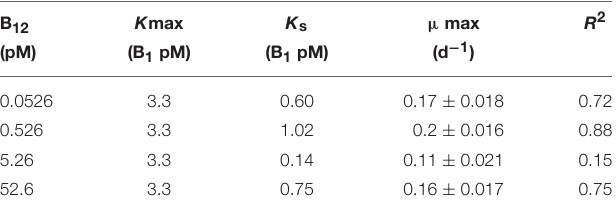
TABLE 1 | Half-saturation constants ( K s) and maximum specific growth rates ( µ ) of L. polyedrum for B 1 and B 12